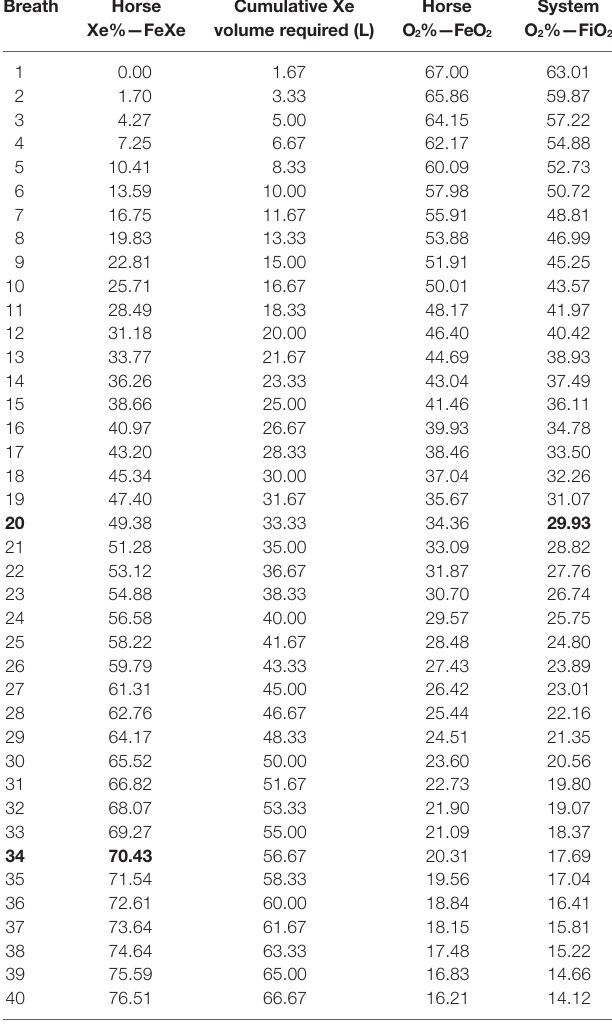
Table 5 | Modeling of wash-in